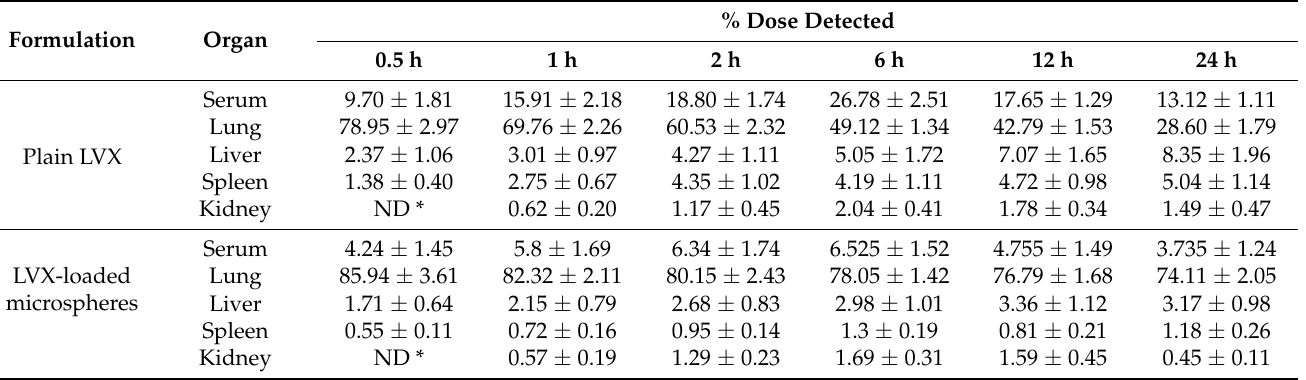
Table 6. In vivo organ biodistribution after pulmonary administration of plain LVX and LVX-loaded